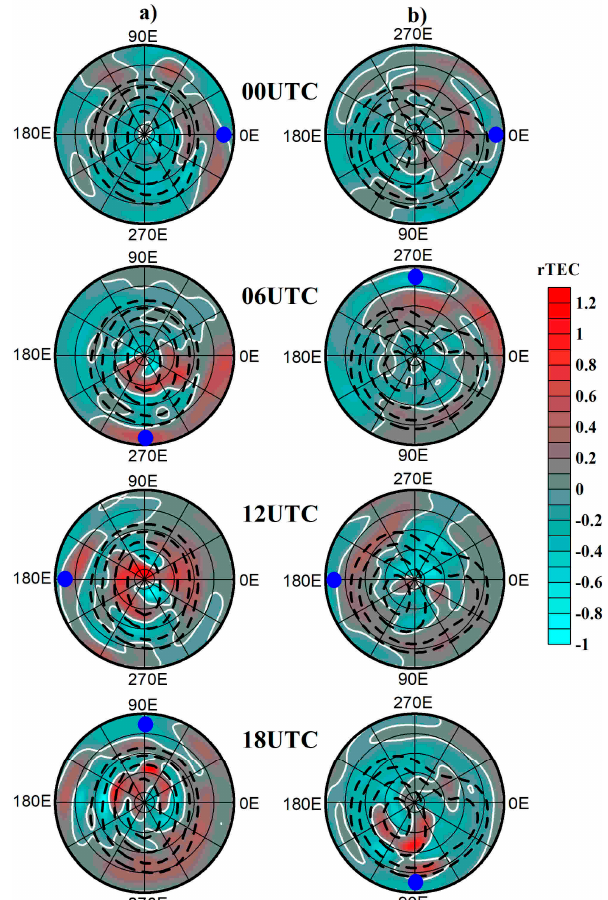
Figure 8. Latitudinal distribution of relative TEC in polar coordinates for 2 April 2022 for the northern hemisphere ( a ) and the southern hemisphere ( b ). Lines of equal inclination of the Earth’s magnetic field from 50° to 80° in 10°are indicated by dotted lines. The blue dots indicate the mid- night meridian.